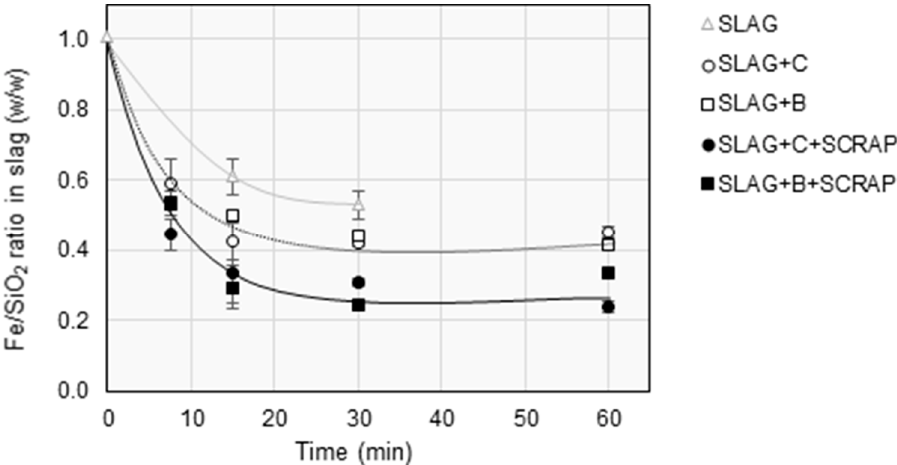
Figure 2. Fe/SiO 2 ratio in slag as a function of reduction time at 1400 °C. Trend lines were drawn for slag melting (SLAG as solid grey line) and coke-containing reduction experiments (SLAG + C as dotted black line and SLAG + C + SCRAP as solid black line).